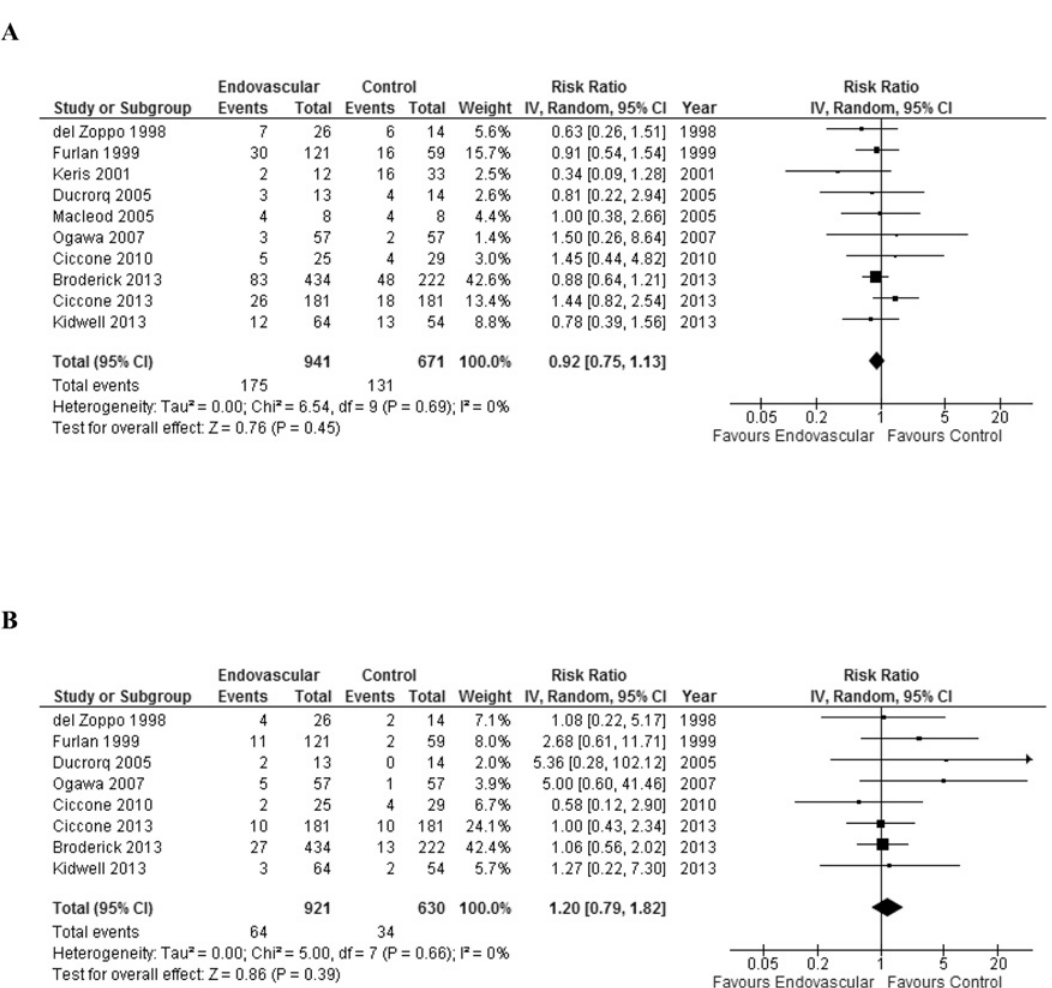
Fig 4. A: Forest plots showing mortality between endovascular therapy and controls. B: Forest plots showing symptomatic intracranial hemorrhage between endovascular therapy and controls.